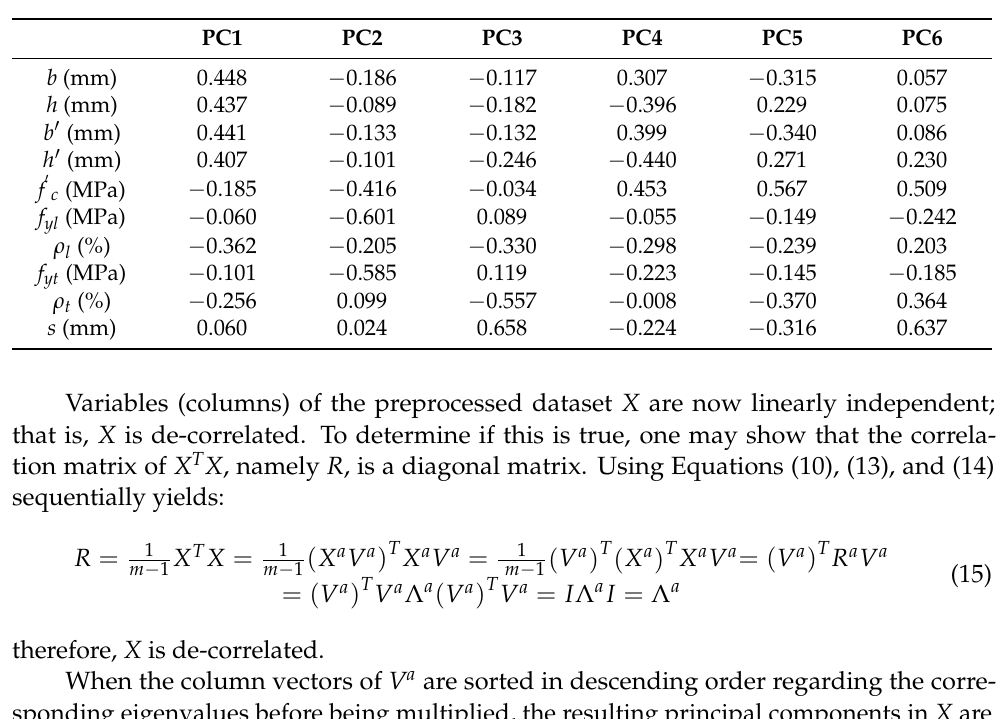
Table 1. Principal component results.